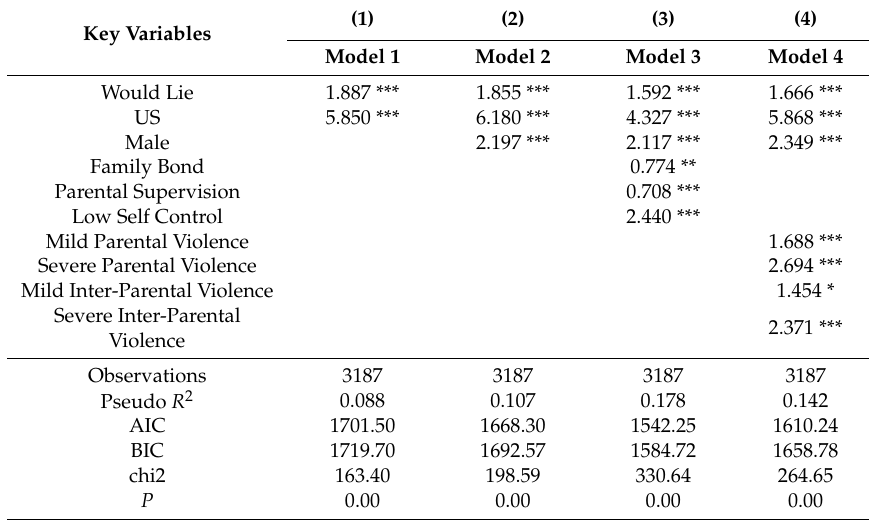
Table 3. Logistic Regression Results: Occurrence of Violent Offending on Key Variables.